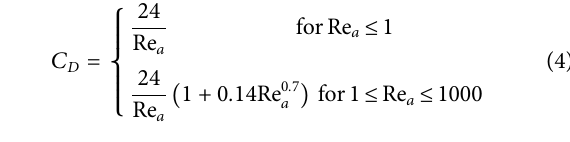
Frontiers in Energy Research |